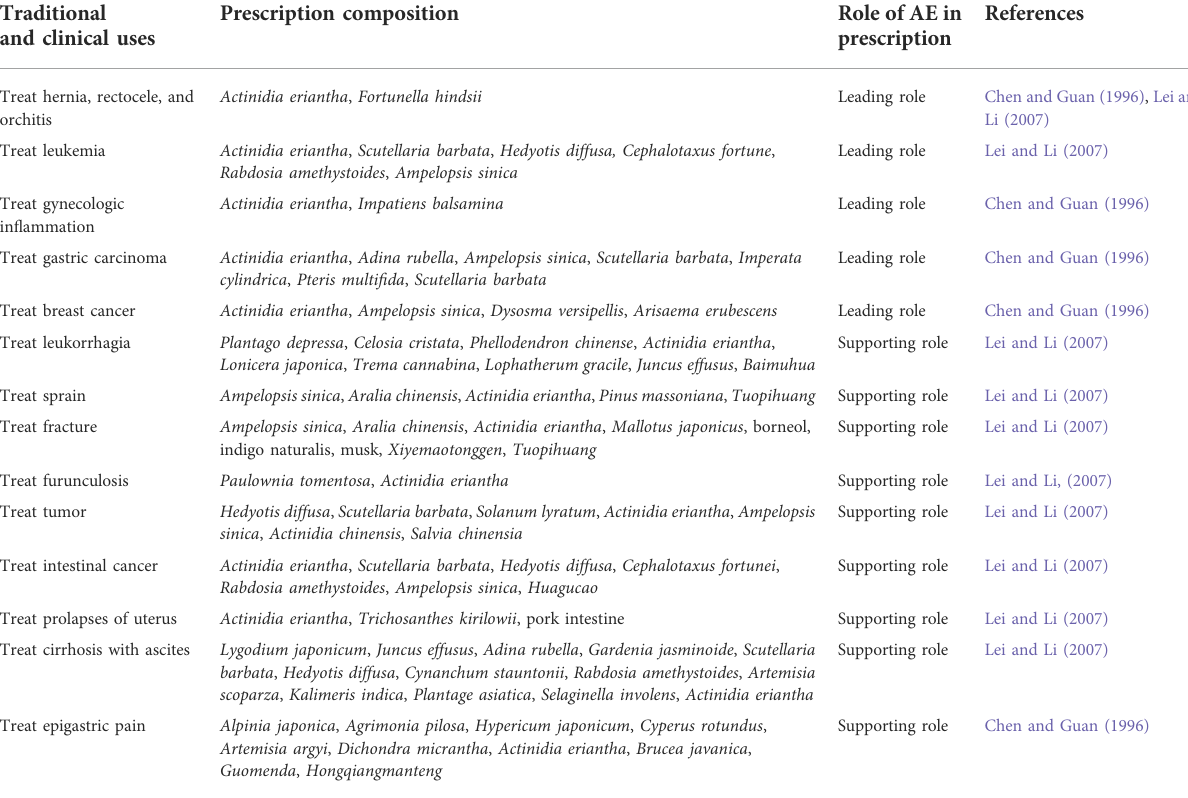
TABLE 3 Examples of traditional Chinese medicine prescriptions containing Actinidia eriantha